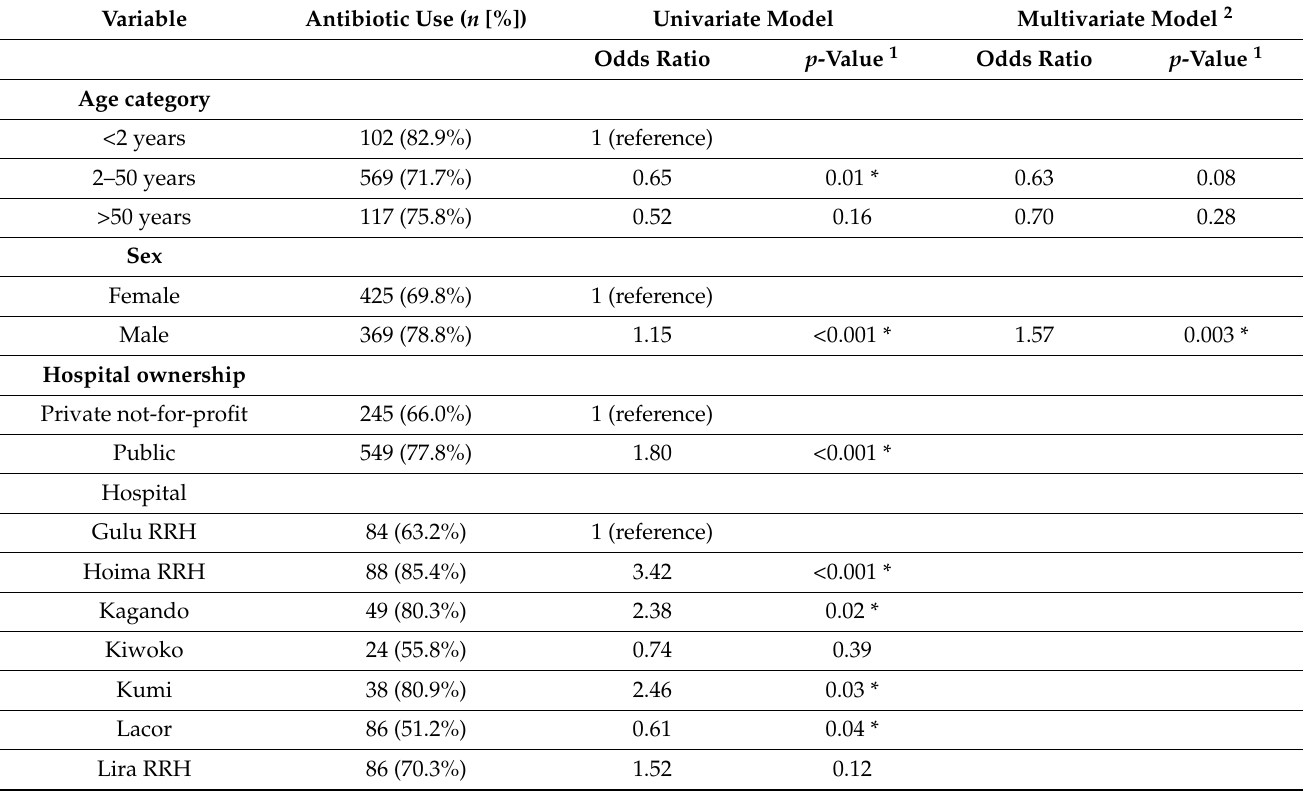
Table 5. Associations of antibiotic use with characteristics of the study